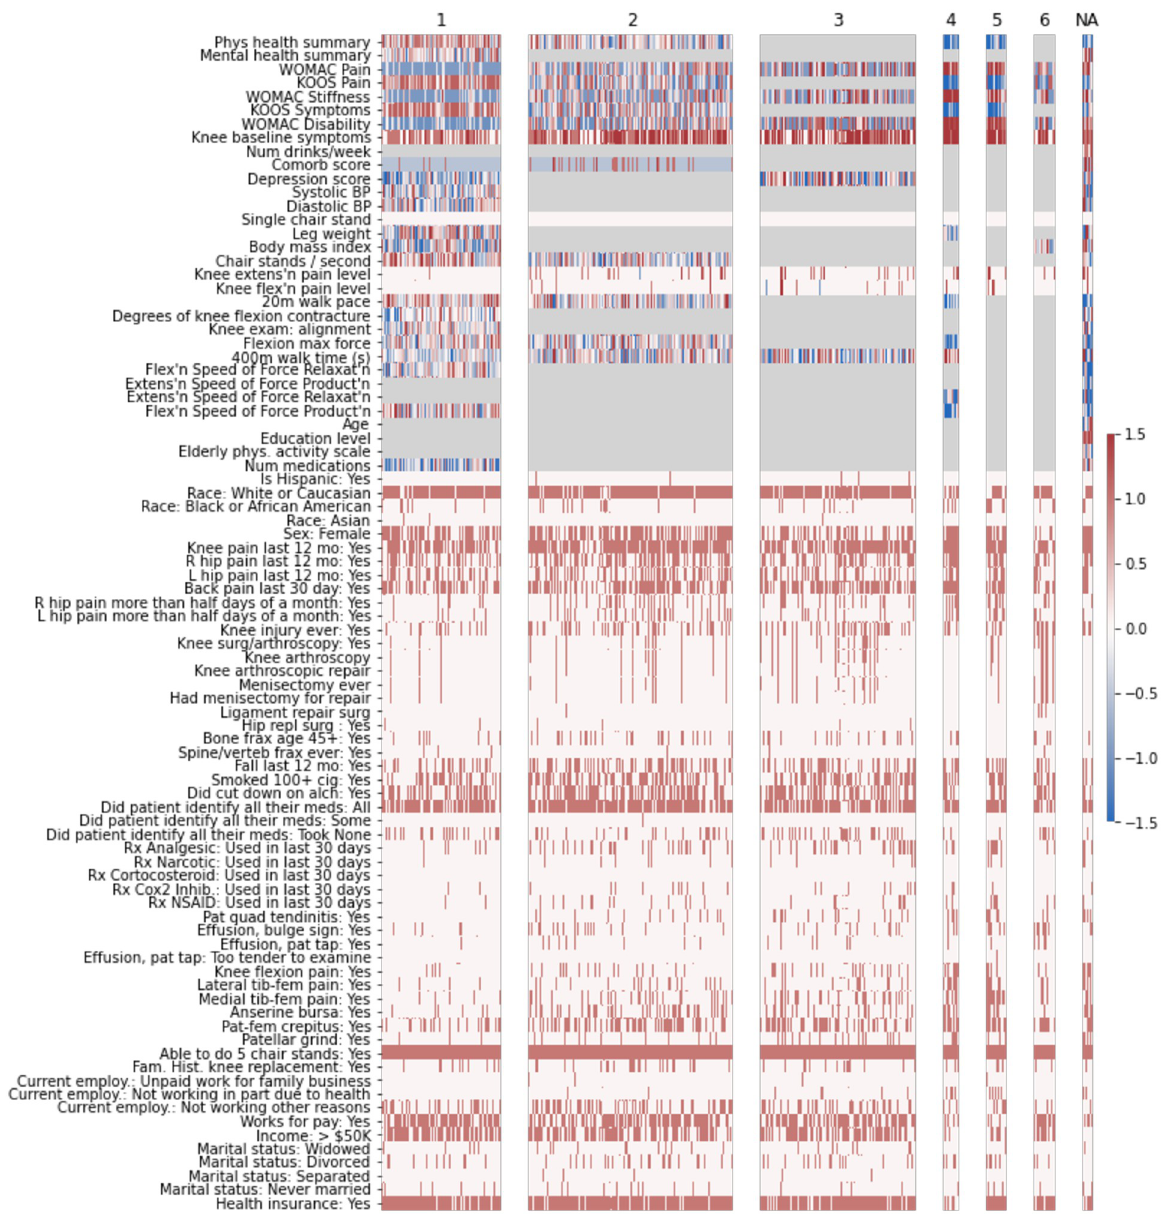
Fig 1. Summary of 6 biclusters in overall data (all knees). This heatmap shows all included variables on the y-axis, and knees on the x-axis. Biclusters are indicated across the top by number. The color scale indicates the direction of the variable on a standardized scale. Features/knees in gray are not included in the bicluster; na indicates that this group of knees were not included in any bicluster. with higher KOOS pain and symptoms, and lower WOMAC scores (all scales). Knees in the bicluster were from individuals with better SF-12 physical summary scale scores and faster 20-meter walk speeds. Other features characterizing this bicluster included fewer depressive symptoms, fewer comorbidities, slightly higher income, and greater employment. Biclusters #2, 3, and 6 had overall similar prognosis compared to the full cohort, but each included different knees and sets of features. The R 2 for these biclusters was around 0.3.